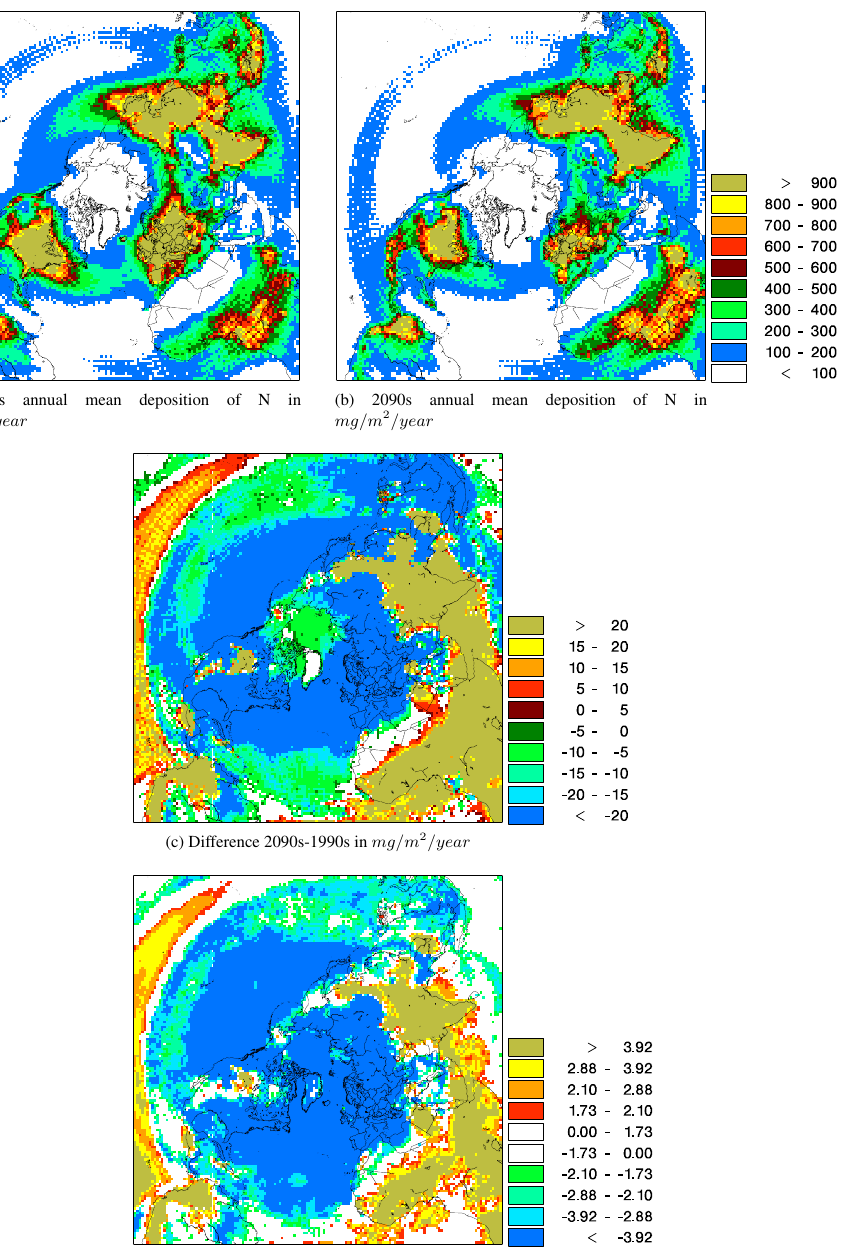
Fig. 9. Total annual mean nitrogen deposition in mg / m 2 / year, displayed as Fig. 1 (including impacts from both climate change and emission Fig. 9: Total annual mean nitrogen deposition in mg = m 2 = year , displayed as Fig. 1 (including impacts from both climate change and emission change).